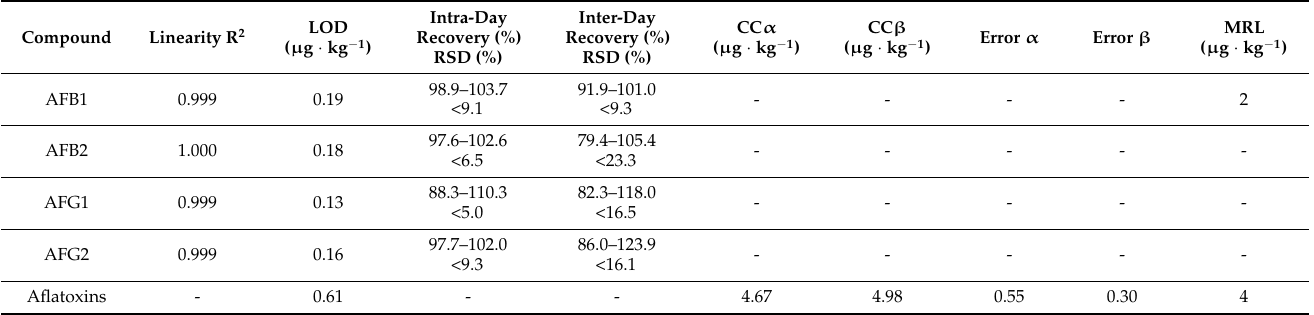
Table 3. Validation parameters for the determination of AFB1, AFB2, AFG1, and AFG2 in